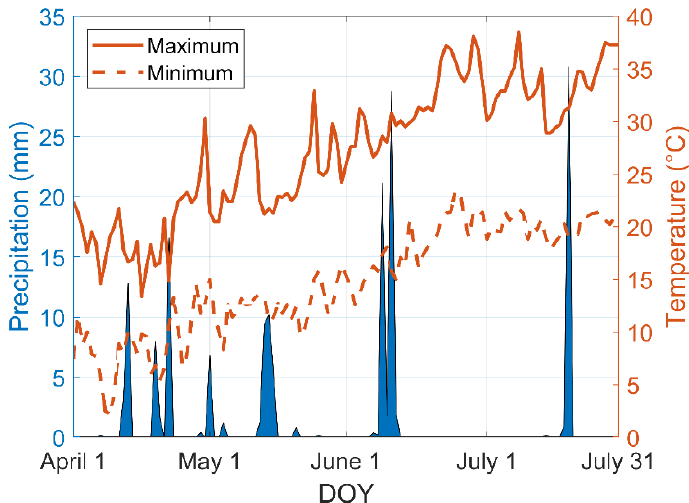
Figure 2. Daily precipitation and maximum and minimum temperatures from 1 April to 31 July 2021. Table 1. Main statistics of the weather observations in April–July of 2008–2021.